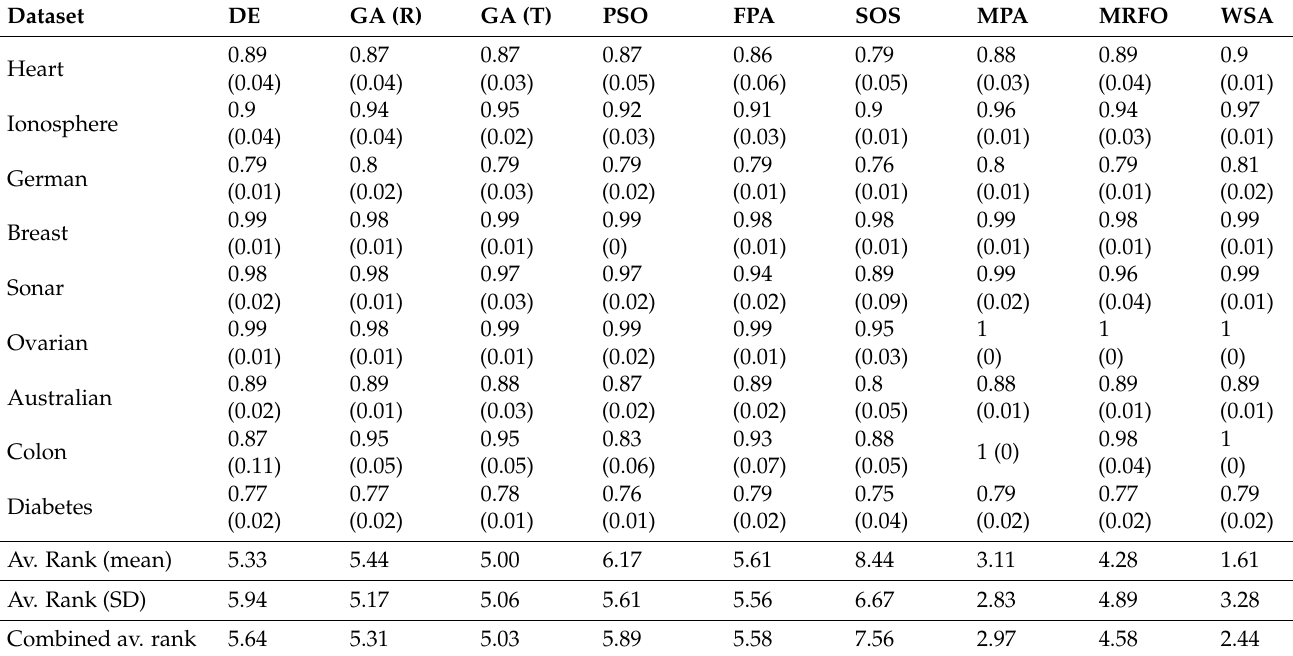
Table 6. Mean (and standard deviation) of best classification accuracy achieved by each algorithm for each dataset in repeated trials.